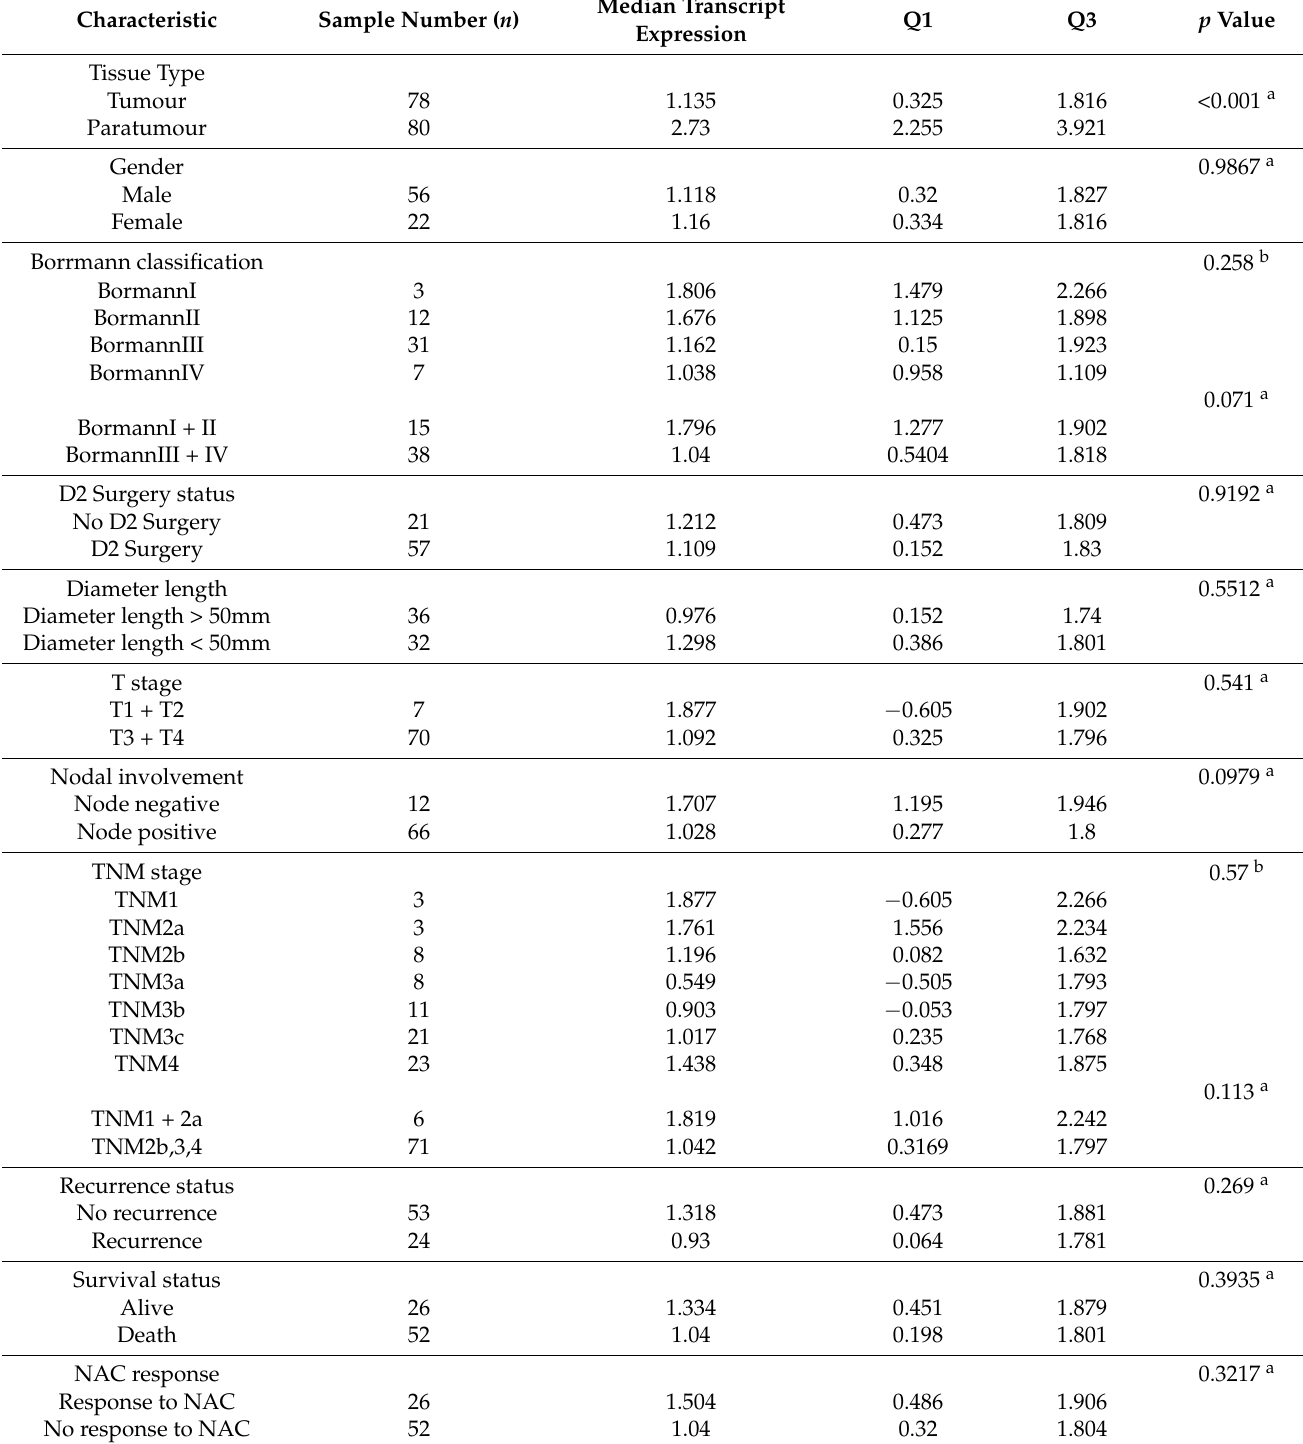
Table 2. EPLN log 10 relative transcript expression in gastric cancer patients with neoadjuvant chemotherapy (NAC) and paratumour